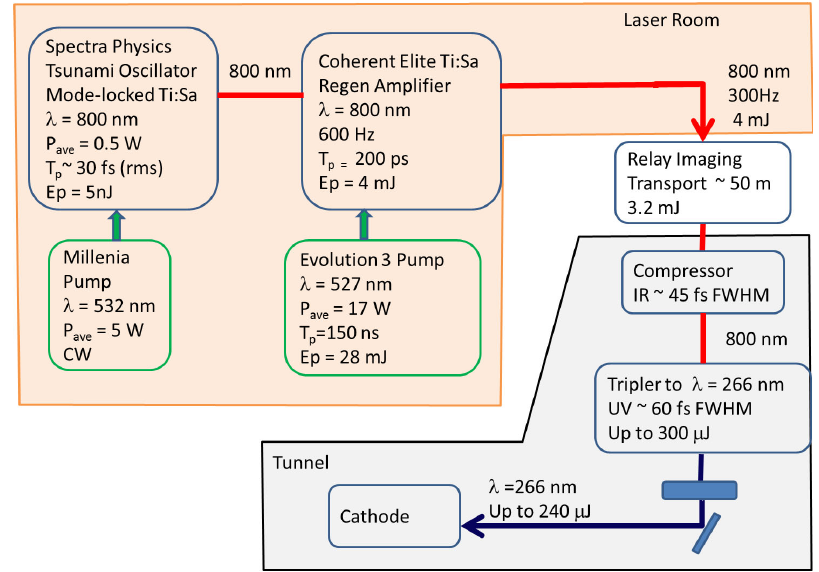
FIG. 5. Schematic of XTA laser